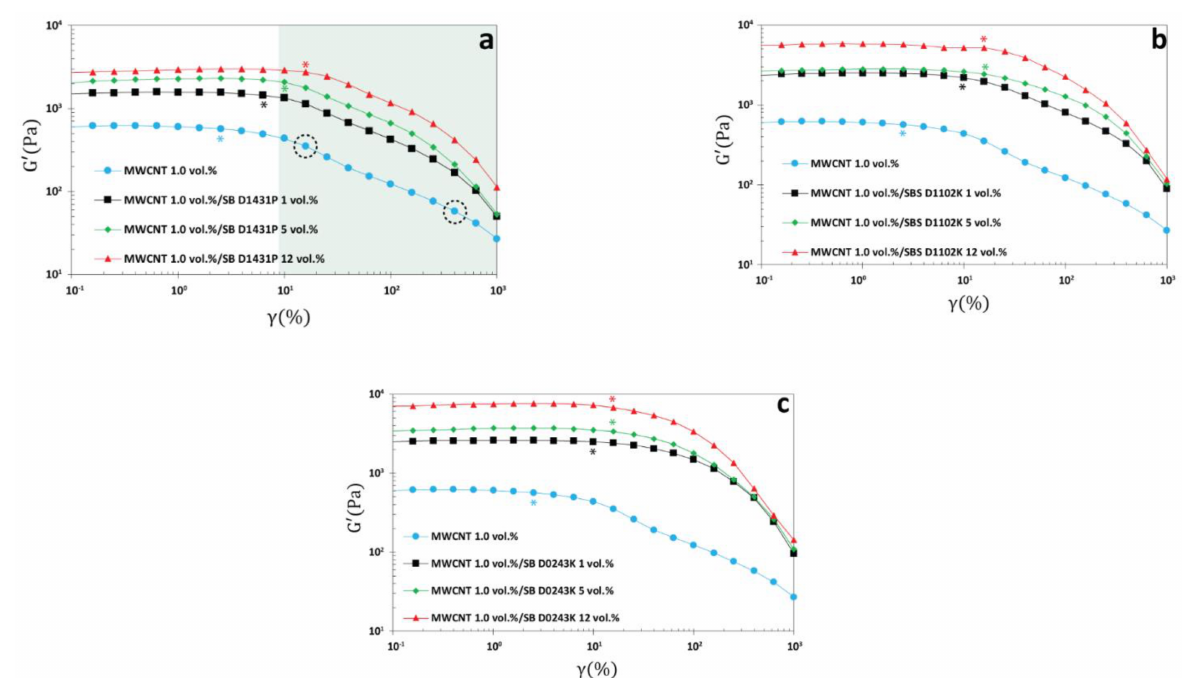
Figure 11. Oscillatory amplitude sweep results of PP:PS/70:30/MWCNT 1.0 vol.% and PP:PS/70:30/MWCNT 1.0 vol.%/copolymer at different block copolymer concentrations. ( a ) PP:PS/70:30/MWCNT 1 vol.%/SB D01431P, ( b ) PP:PS/70:30/MWCNT 1 vol.%/SBS D1102K, and ( c ) PP:PS/70:30/MWCNT 1 vol.%/SB D0243K. The star symbols correspond to the transition from linear to nonlinear regimes. Shaded area in ( a ) highlight the two-step-yielding. Dashed circles represent the two yielding points in the PP:PS/70:30/MWCNT 1.0 vol.% in the absence of copolymer. Strain sweep tests were performed at 200 ◦ C and an angular frequency of ω = 1.0